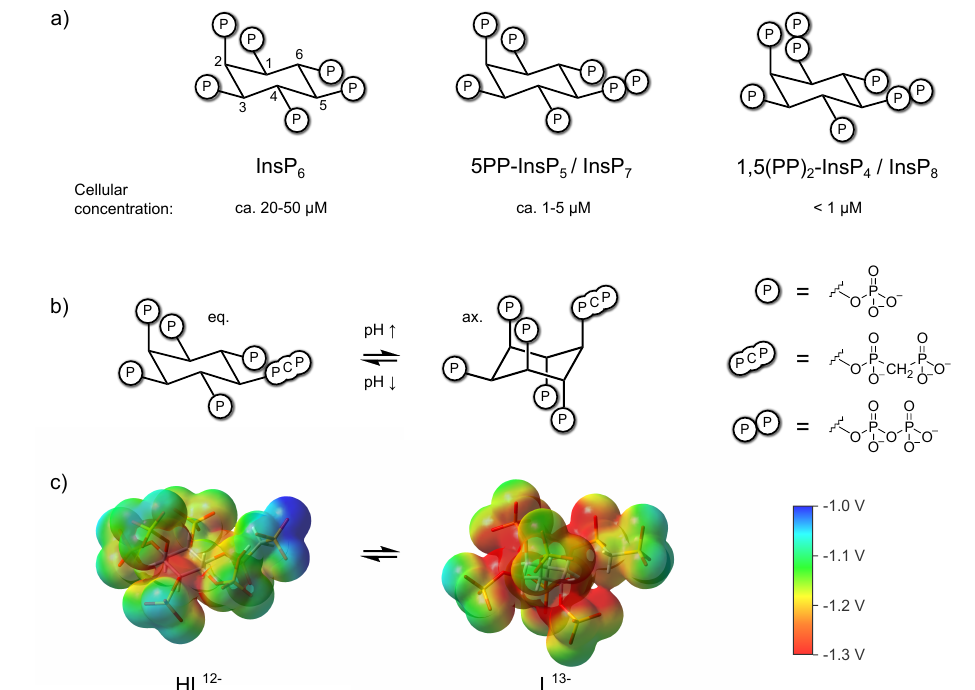
Figure 1. ( a ) Structure of InsP 6 , 5PP-InsP 5 , InsP 8 and approximate concentrations in mammalian cells [29–32]. ( b ) pH-dependent equilibrium between axial (ax.) and equatorial (eq.) conformation of the non-hydrolyzable 5PP-InsP 5 analogue 5PCP-InsP 5 [28] ( c ) Electrostatic potential mapped on an isodensity surface for fully deprotonated, axial 5PCP-InsP 5 (L 13 − ) and monoprotonated, equatorial 5PCP-InsP 5 (HL 12 − ) (B3LYP/3-21 + G* geometries; isodensity value = 0.004, scale: − 1.3 V (red) to − 1.0 V (blue)). Atom color code: C (grey), H (white), O (red), P